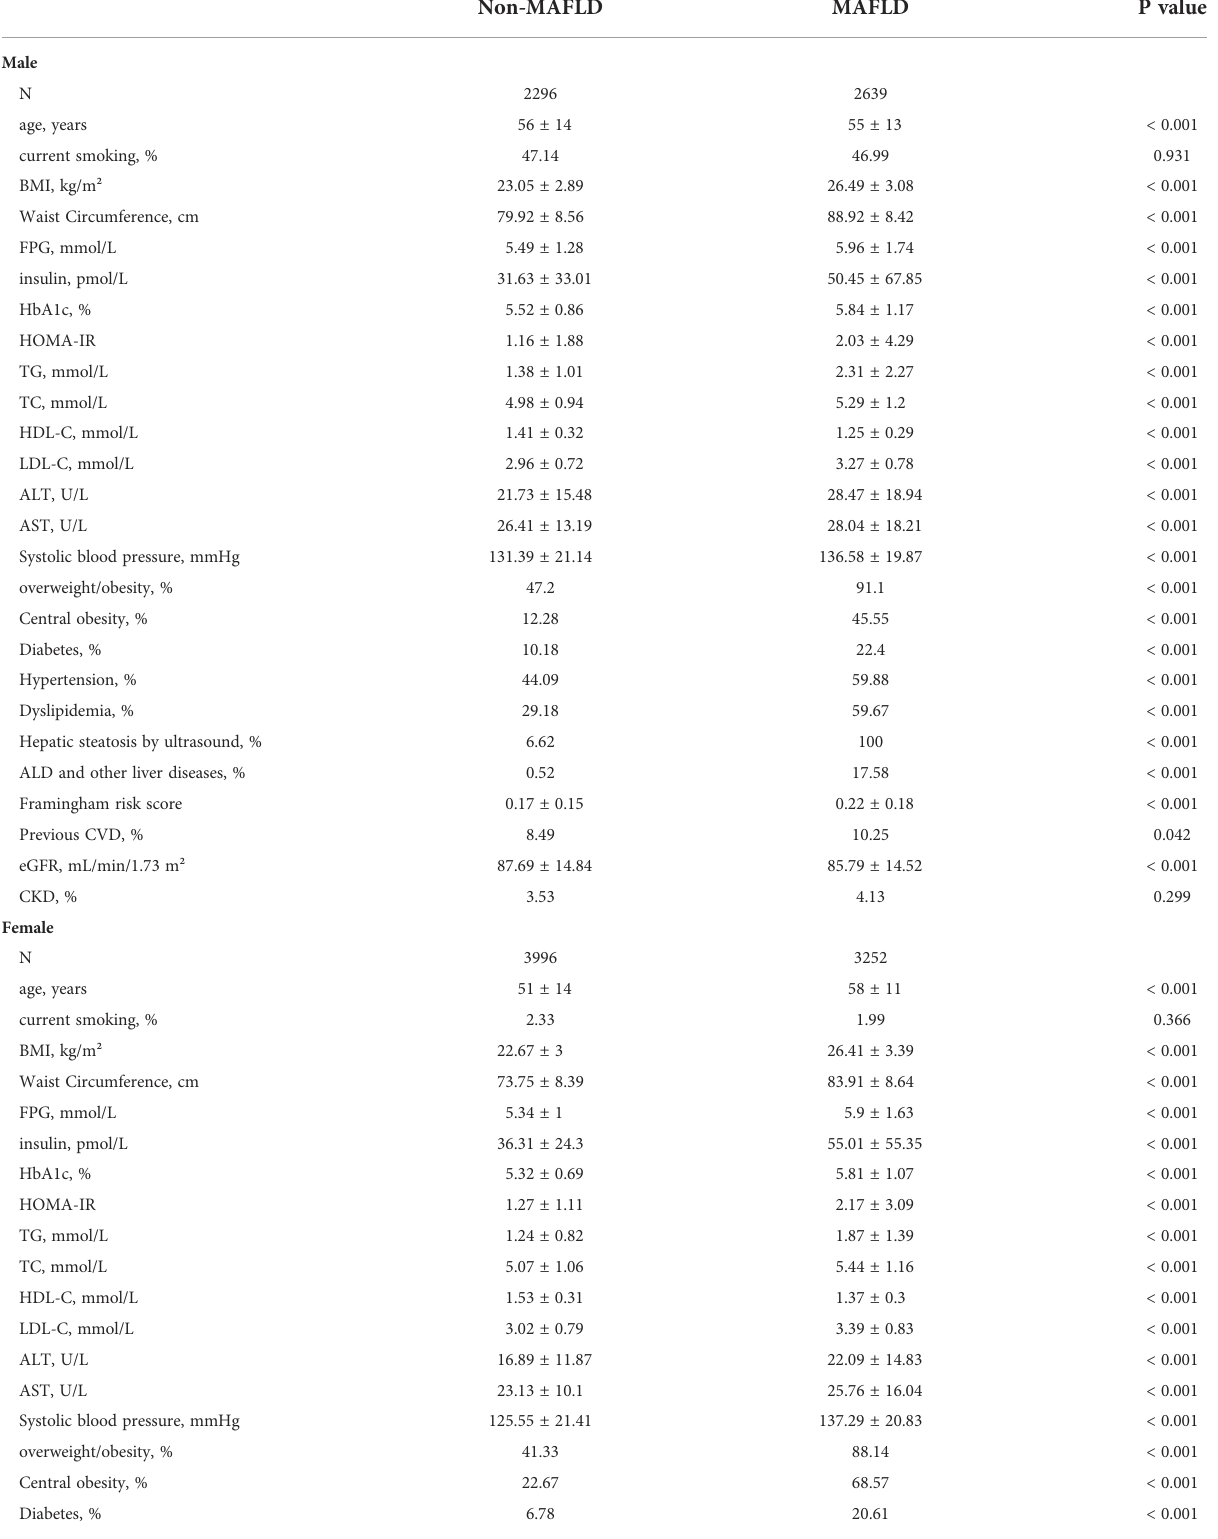
TABLE 1 Clinical characteristics of participants with and without